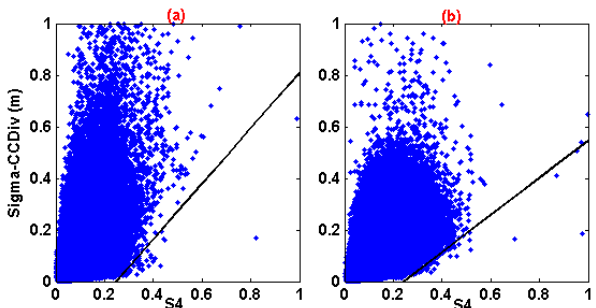
Fig. 2. The signal-to-noise or multipath effects for (a) Bandung and Figure 2. Signals with noise or multipath effects for (a) Bandung and (b) Pontianak data. 3 (b) Pontianak data. The data with a sigma-CCDiv value above the Signals with sigma-CCDiv value above the line are excluded in data analysis. 4 line were excluded from the data